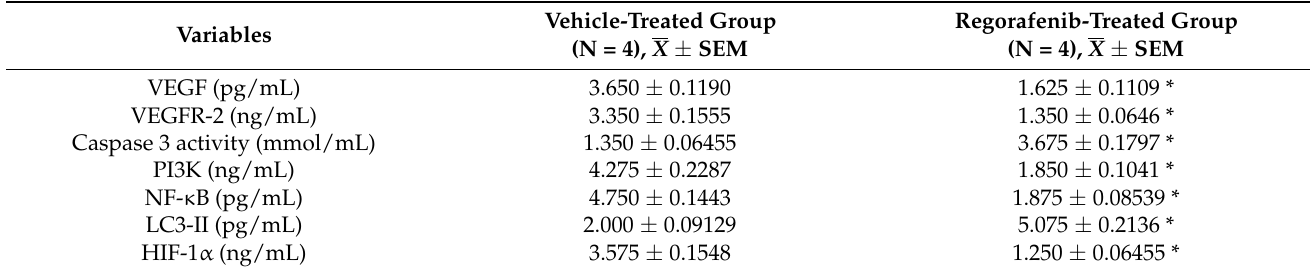
Table 2. The effect of regorafenib in MCF7 cell lysate.